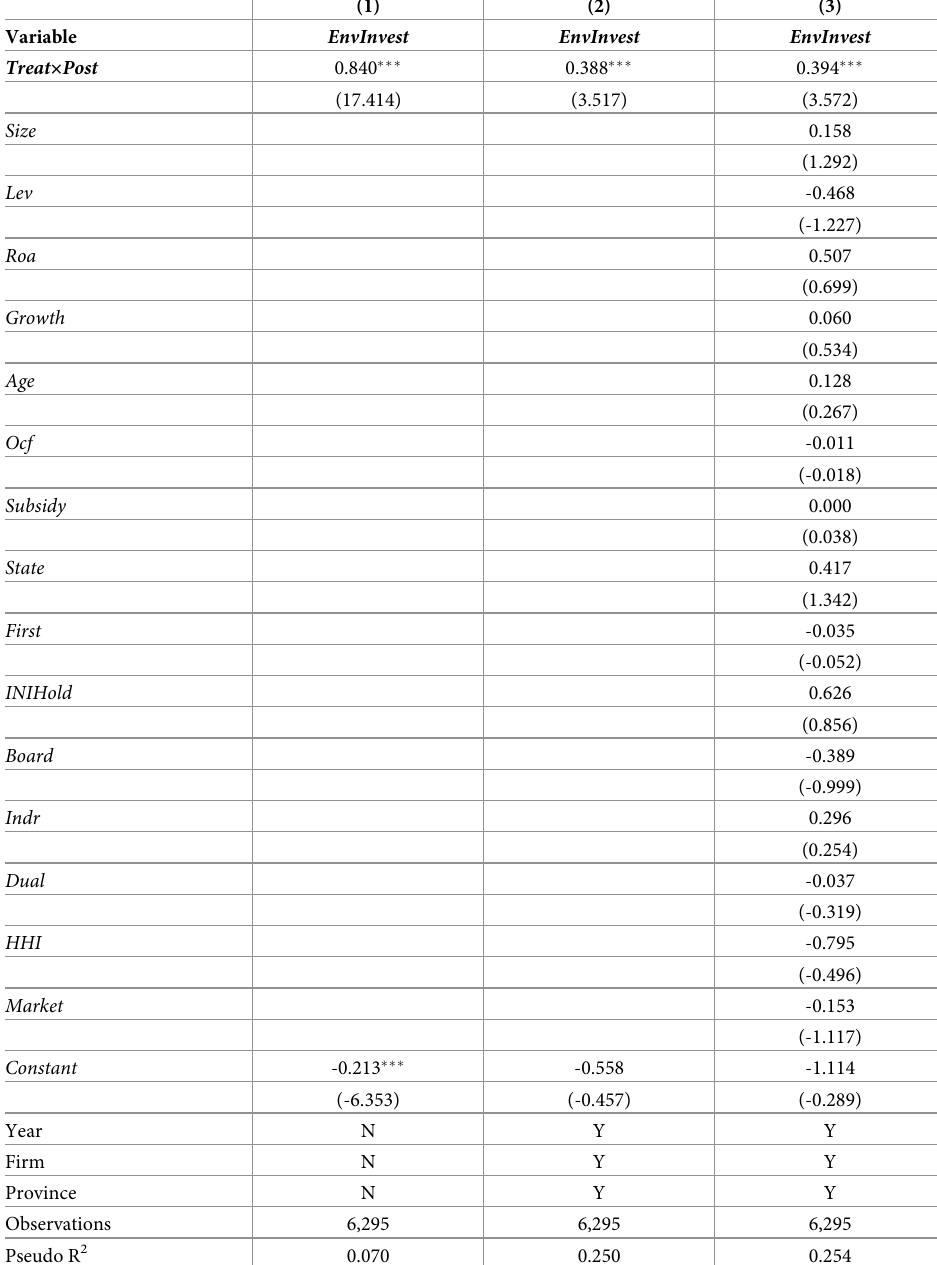
Table 5. Alternative measures of firms’ environmental investment